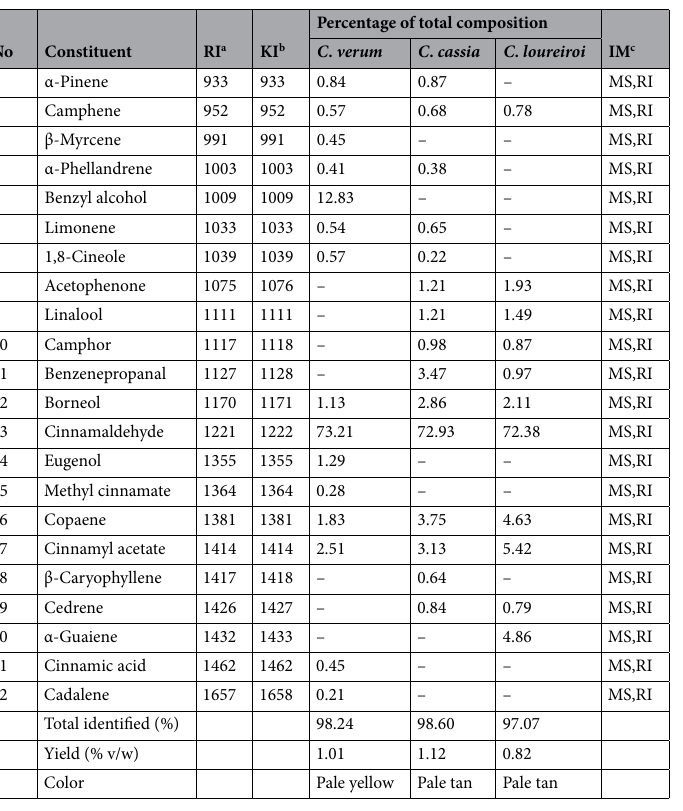
Table 1. Physical property, chemical constituents of C . verum , C . cassia , and C . loureiroi essential oils. a RI = Retention index analyzed with HP-5 MS column, experimentally determined using standard alkanes (C 7 –C 30 ). b KI = Kovats index from https ://pubch em.ncbi.nlm.nih.gov and NIST (https ://webbo ok.nist.gov). c IM = Identification methods; MS, mass spectrum matching with chemicals in the computer mass library of Adams 61